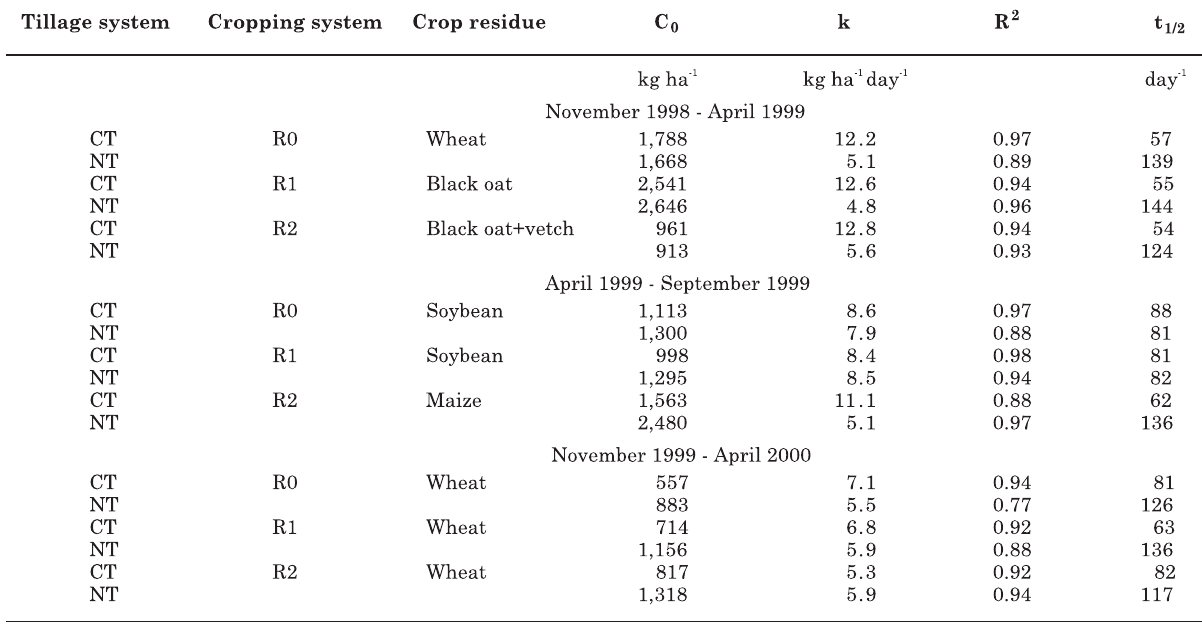
Table 1. Initial C (C ), decay constant rate (k), determination coefficient (R 2 ) and half-life (t 0 residues in mesh-bags under influence of two soil tillage systems (CT= conventional tillage and NT= no tillage) and three cropping systems (R0: soybean/wheat; R1: soybean/wheat/soybean/black oat;